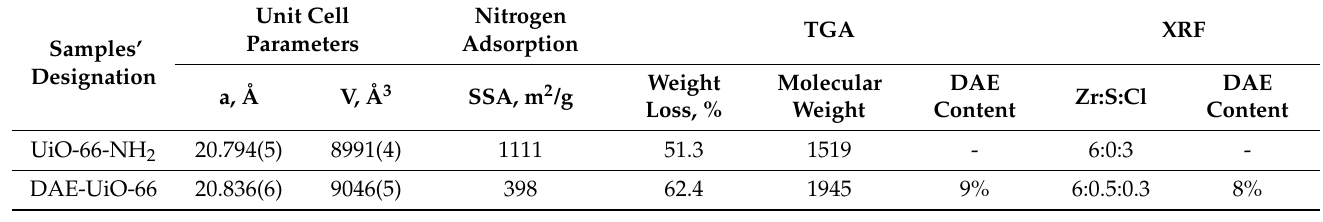
Table 1. Some properties of the synthesized samples UiO-66-NH 2 and DAE-UiO-66. SSA stands for the specific surface area. DAE content was calculated in mol %.